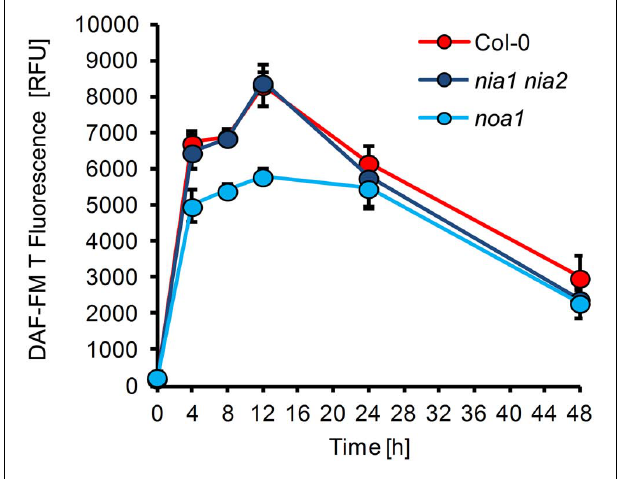
et al., 2010). Although the noa1 mutant is defective in a plastidic GTPase rather than NOS (Moreau et al., 2008; Gas et al.,